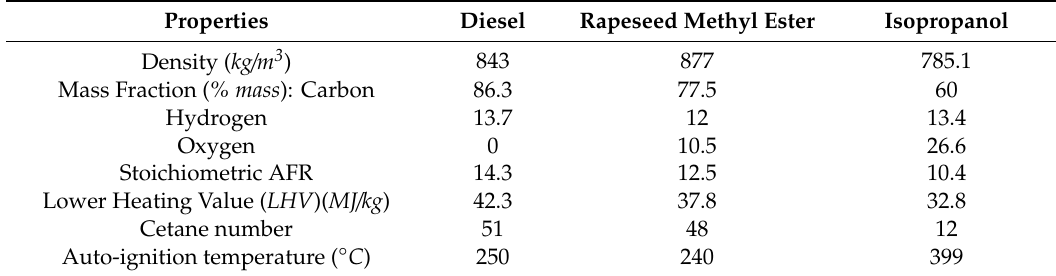
Table 1. Properties of 100% pure diesel, rapeseed methyl ester and